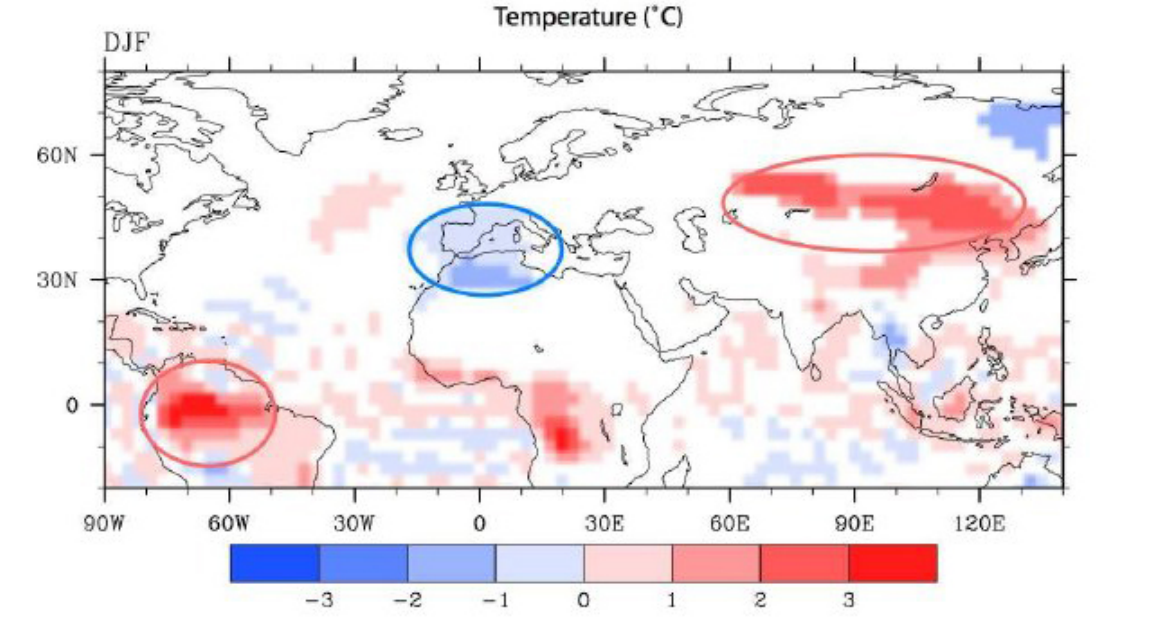
Fig. 5. Simulated global surface temperature changes as a result of converting the tropical forest basins of the Amazon, Africa, and the Indian archipelago from rainforest to bare ground. In this simulation, changes in the tropical forest vegetation cover of the Amazon cause widespread temperature changes in the region, but also significant tele-connections to other parts of the world, including western Europe and central Asia. This simulation was performed by the CCM3 climate model, coupled to the IBIS land surface / ecosystem model (Snyder et al.